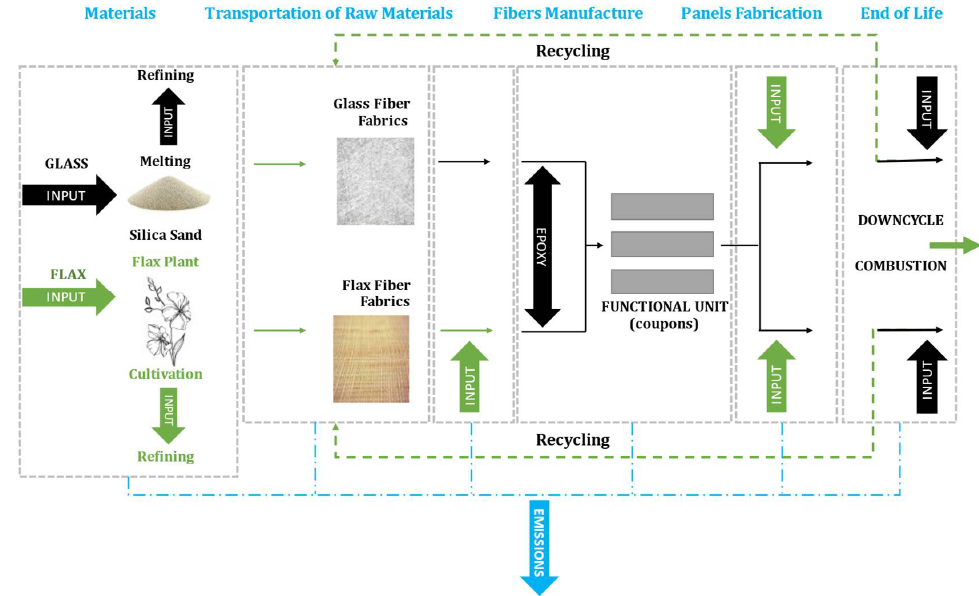
Figure 5. Boundaries of the eco-impact analysis for the laminate’s fabrication .